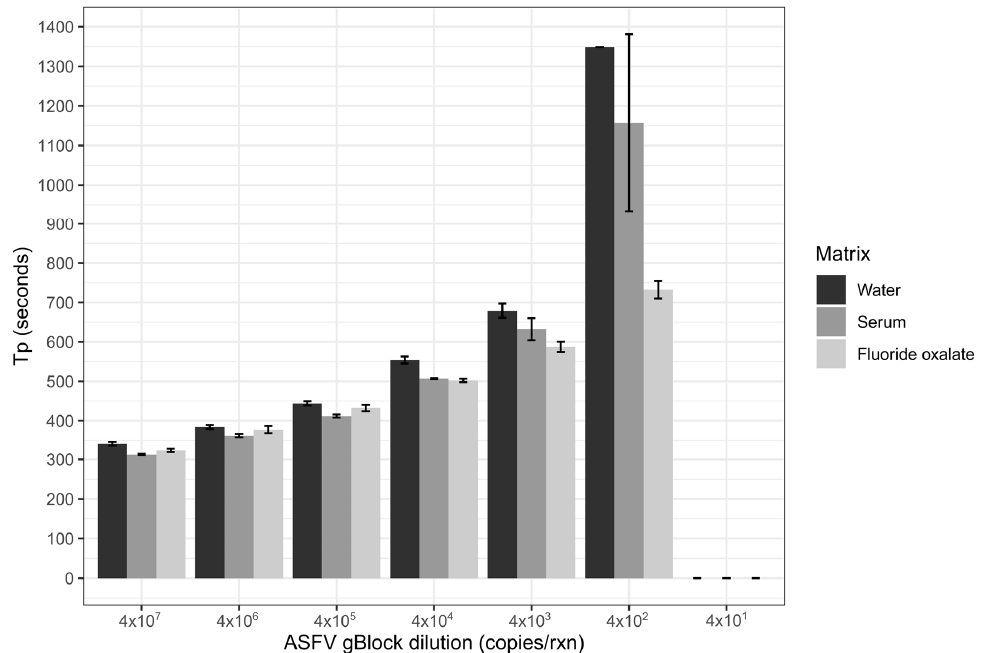
Figure 1. Limit of detection of the ASFV LAMP performed with the ASFV gBlock in three different sample matrices. The sample matrices of serum and fluoride oxalate blood were diluted 1 in 10 in nuclease-free water before being spiked with the ASFV gBlock. All runs were performed in triplicates with error bars representing the standard deviation.